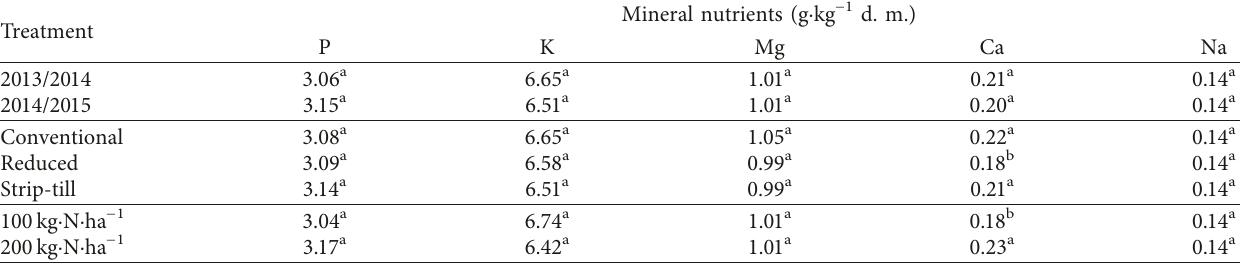
Table 3: Quality of grain and wheat flour depending on the research year, tillage, and nitrogen fertilisation (experimental treatments). Treatment Protein content in grain